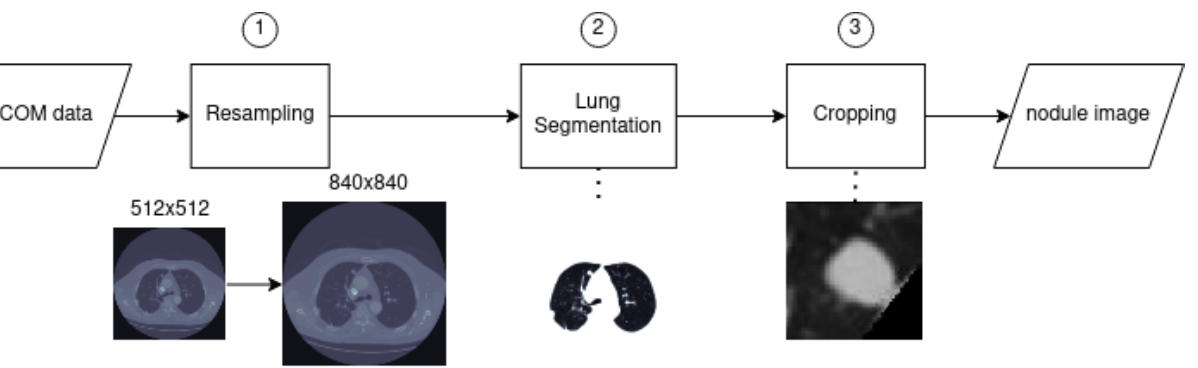
Figure 10. Preprocessing